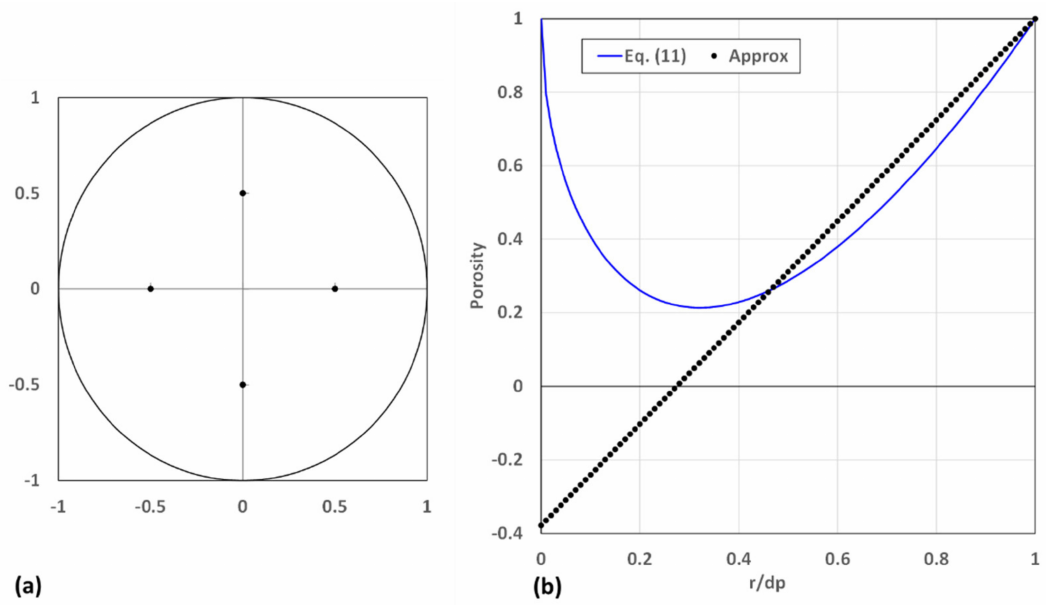
Figure 5. ( a ) Positions of centres of the spheres and ( b ) the radial variations in porosity based on Equation (11) and the approximate expressions for D / d p =